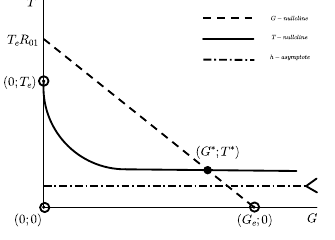
Fig. 1: Different Equilibria and their stability/instability properties when R 01 > 1 and ω ( G e ) R 10 > 1 . Solid circles indicate a stable equilibrium, and open circles indicate an unstable equilibrium. There are four equilibria. Only coexistence equilibrium is GAS (see Tables I and II).